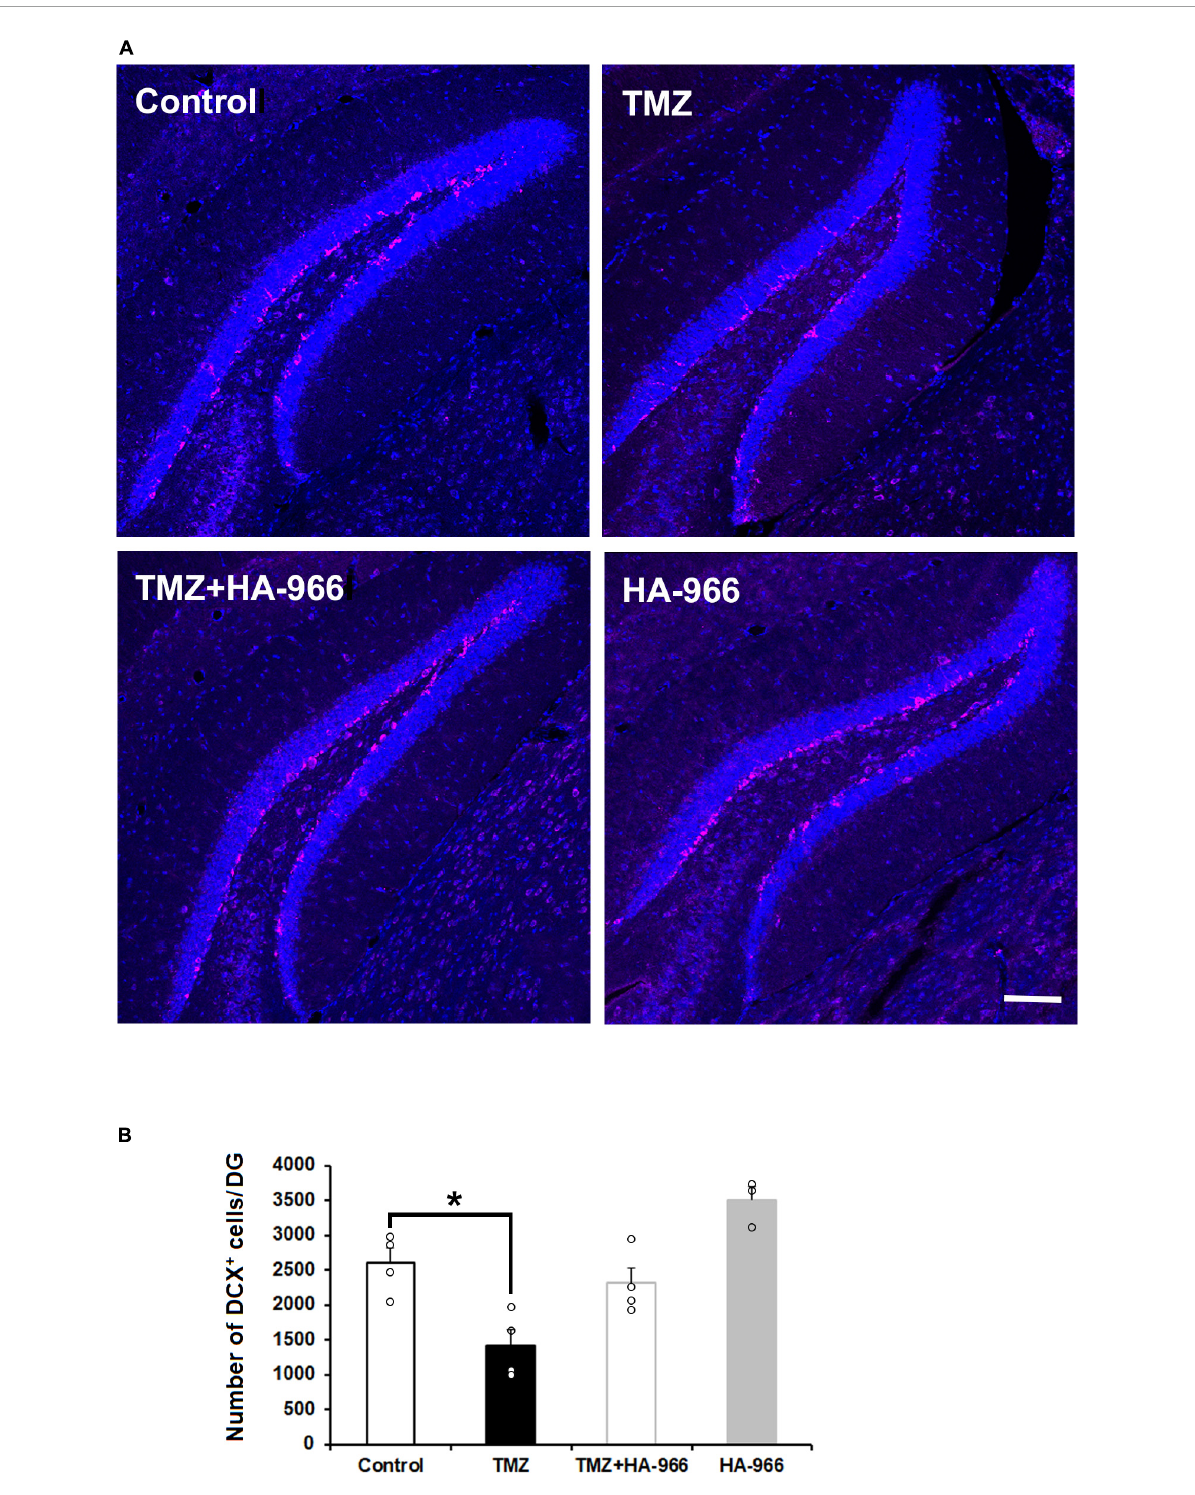
FIGURE4 Effects of TMZ and HA-966 treatment on hippocampal neurogenesis. (A) Immediately after the fourth retrieval on day 28, mouse brains were removed and stained using anti-doublecortin (DCX) antibody (magenta) and DRAQ5 (blue). Scale bar, 100 µ m. (B) Quantification of DCX-positive (DCX + ) cells in the dentate gyrus (DG) of control ( n = 4), TMZ ( n = 4), TMZ + HA966 ( n = 4), and HA-966 ( n = 3) groups. Data are presented as the means ± SEM. * p <